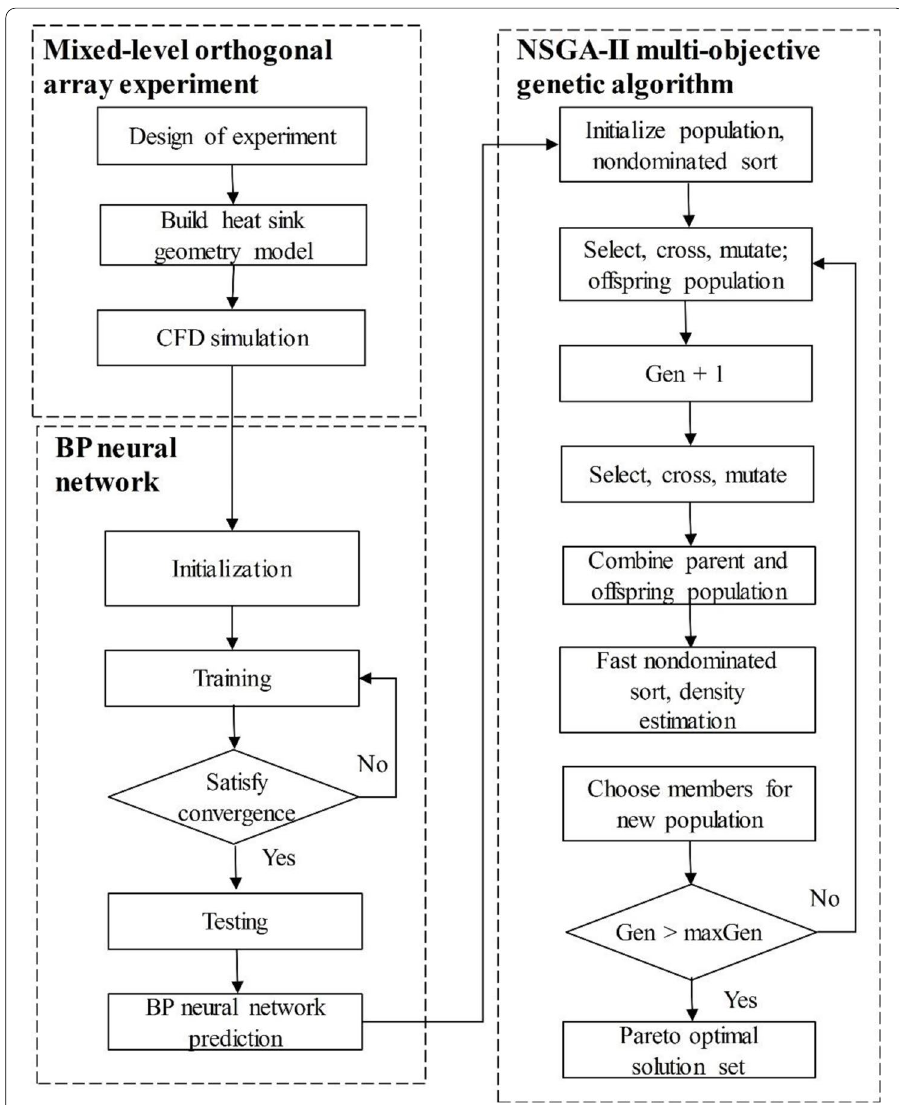
Fig. 7 Flowchart of the multi-objective